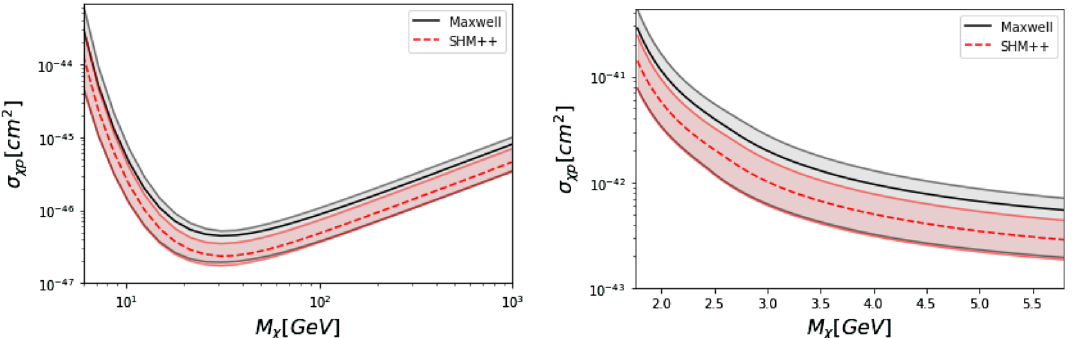
Fig. 12 InfluenceoftheuncertaintyontheDMvelocitydistributionon XENON1T (left) and DarkSide-50 (right) 90% excluded SI cross sec- tions. The allowed region for the Maxwell distribution (shaded black)